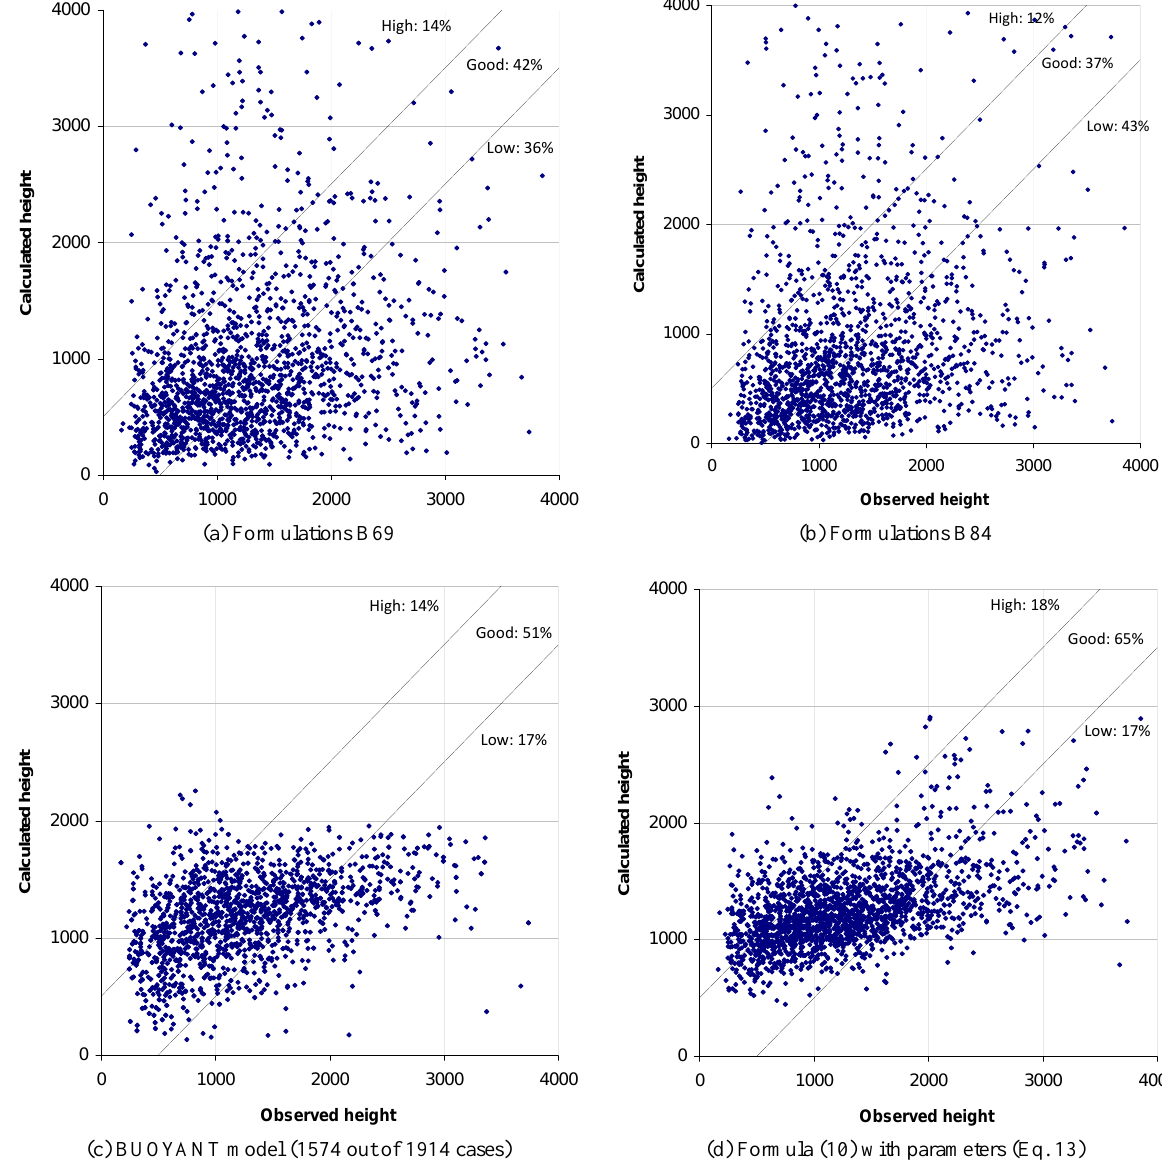
Fig. 2. Comparison of B69 (Eq. 17), B84 (Eq. 18), BUOYANT, and formula (10, 13) for the whole MISR set. variability of the latent and sensible heat ratios to FRP. Figure 2. Comparison of B69 (eq ( 17 )), B84 (eq ( 18 )), BUOYANT, and formula ( 10 ), ( 13 ) for Figure 2. Comparison of B69 (eq ( 17 )), B84 (eq ( 18 )), BUOYANT, and formula ( 10 ), ( 13 ) for Figure 2. Comparison of B69 (eq ( 17 )), B84 (eq ( 18 )), BUOYANT, and formula ( 10 ), ( 13 ) for the whole MISR set. the whole MISR set. the whole MISR set. Figure 2. Comparison of B69 (eq ( 17 )), B84 (eq ( 18 )), BUOYANT, and formula ( 10 ), ( 13 ) for the whole MISR set.